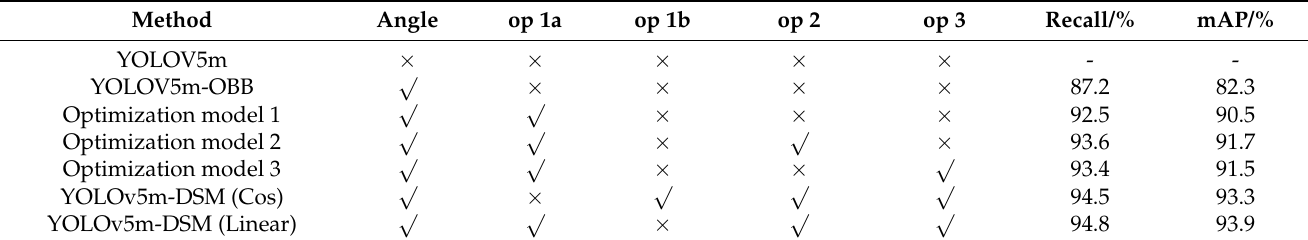
Table 3. Ablation